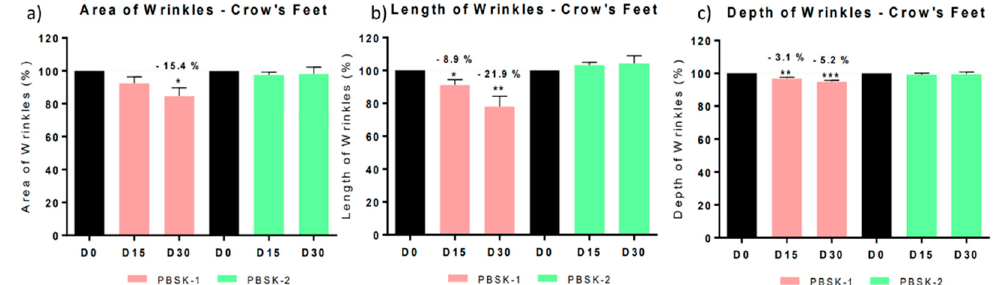
Figure 13. Graphical representation of the total area ( a ), length ( b ) and depth ( c ) of Crow’s feet wrinkles before (D 0 ), after 15 days of treatment (D 15 ) and after 30 days of treatment (D 30 ), with mask PBSK-1 or mask PBSK-2, in 30 human volunteers, comparing each volunteer with its own control at day 0. Statistical significances: * p < 0.05; ** p < 0.01; and *** p < 0.001.